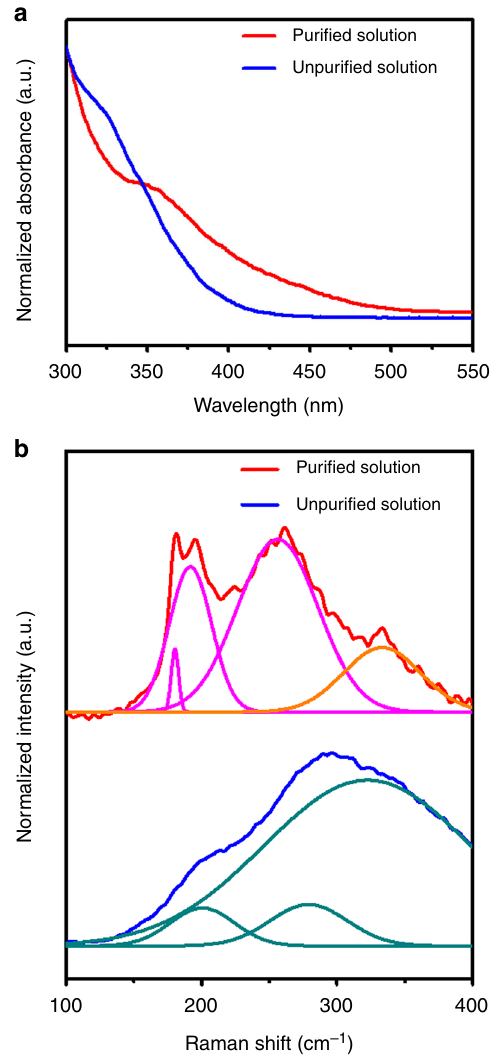
Fig. 2 Synthesis of the SnSe ChaM precursor. a UV-Vis absorption spectra of SnSe precursors before and after the puri fi cation. The distinctive peak at 350 nm for the puri fi ed solution matches the reported absorption band of Sn 2 Se 6 4 − ChaM. b Raman spectra of SnSe precursors before and after the puri fi cation. While broad and unidenti fi able peaks were observed with unpuri fi ed precursor, after puri fi cation, several clear peaks were emerged at 191 and 257 cm − 1 , and at 180 cm − 1 , which are well matched with the vibration modes of the reported Sn 2 Se 6 4 − and Sn 4 Se 10 4 − ChaMs, respectively. Pink, orange, and turquoise curves represent deconvolution